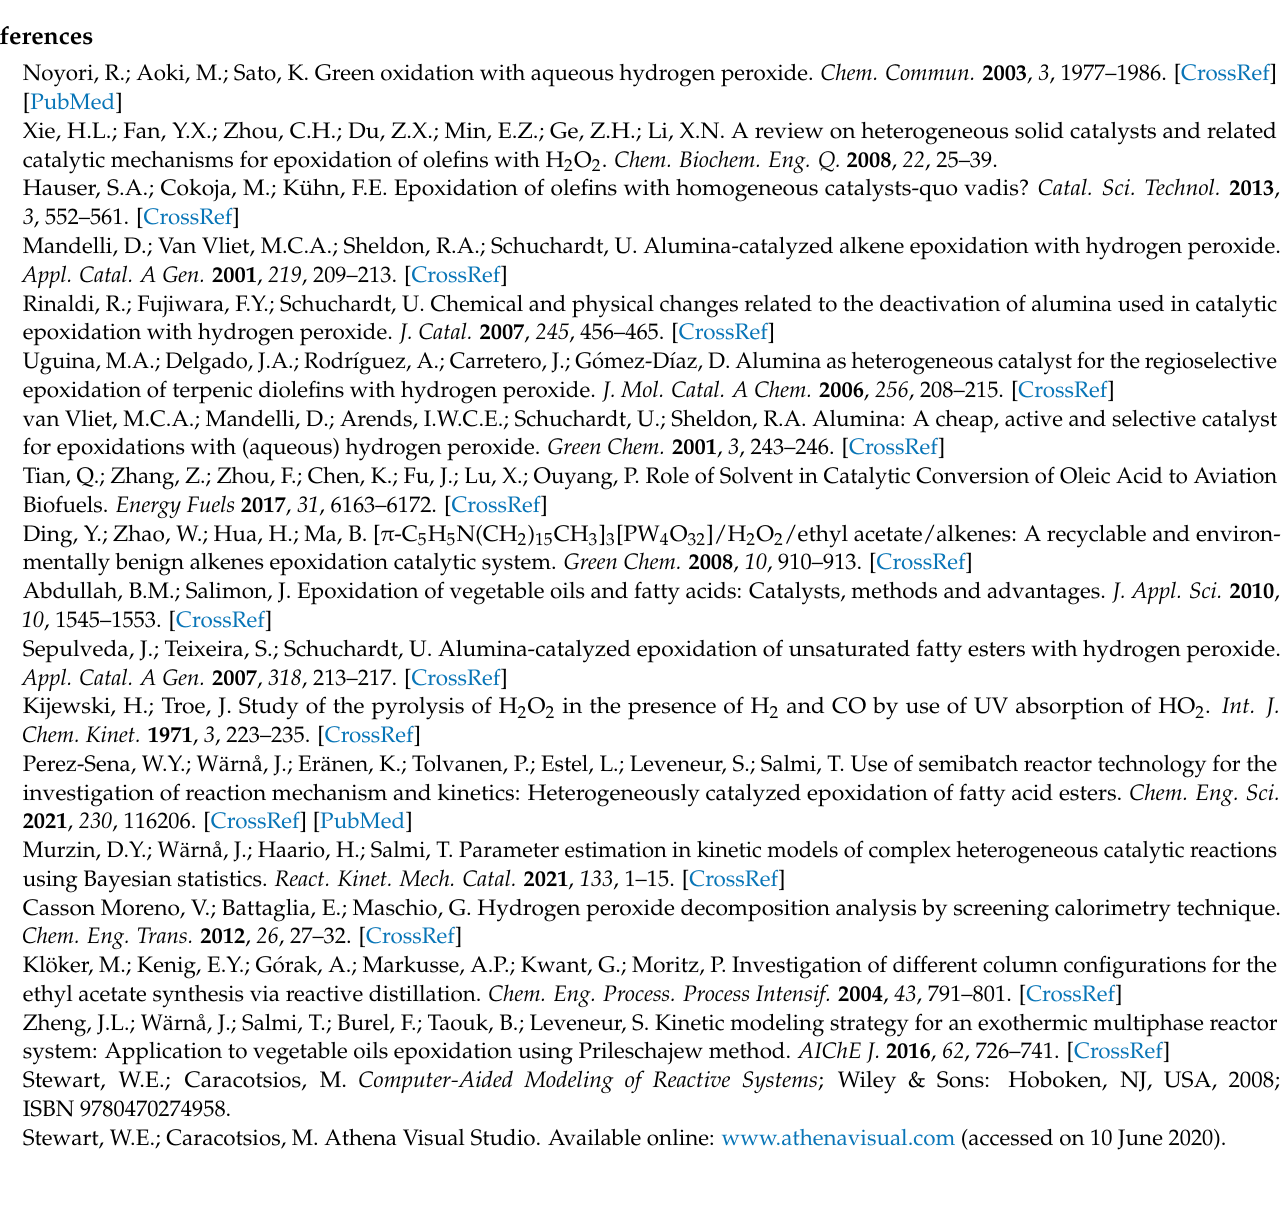
Figure A5. Prediction intervals of 95% for the concentration of hydrogen peroxide in the aqueous and organic phases, using the average of the experimental data and setting K 1,org = 0 and K 1,aq = 15.05 for Experiment 12.